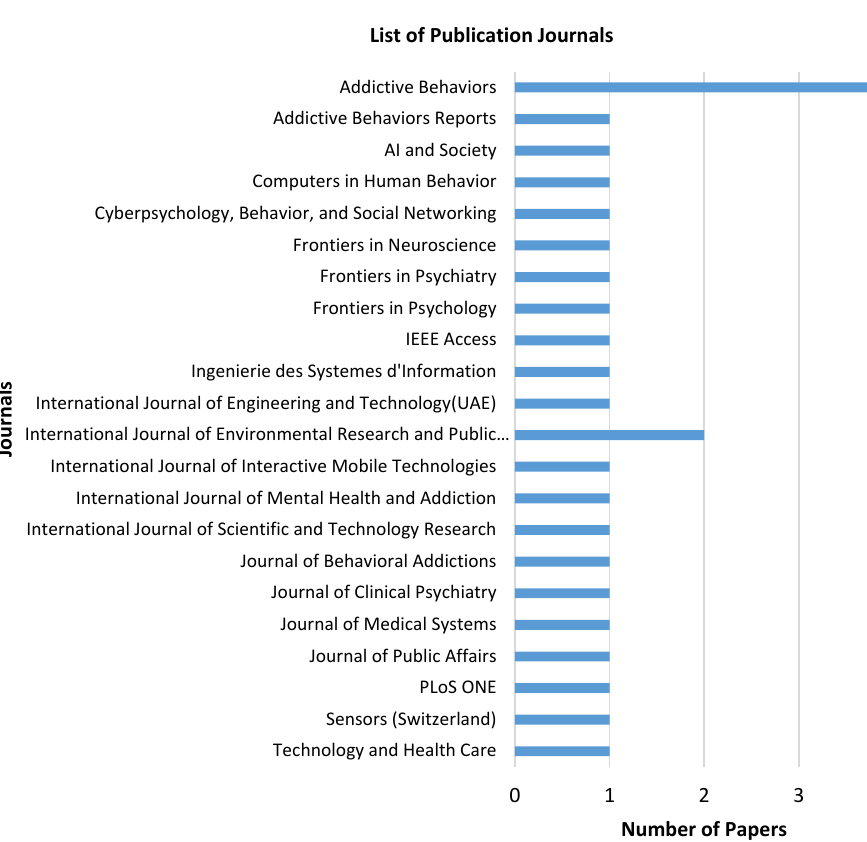
Figure 4. List of journals and publication numbers .